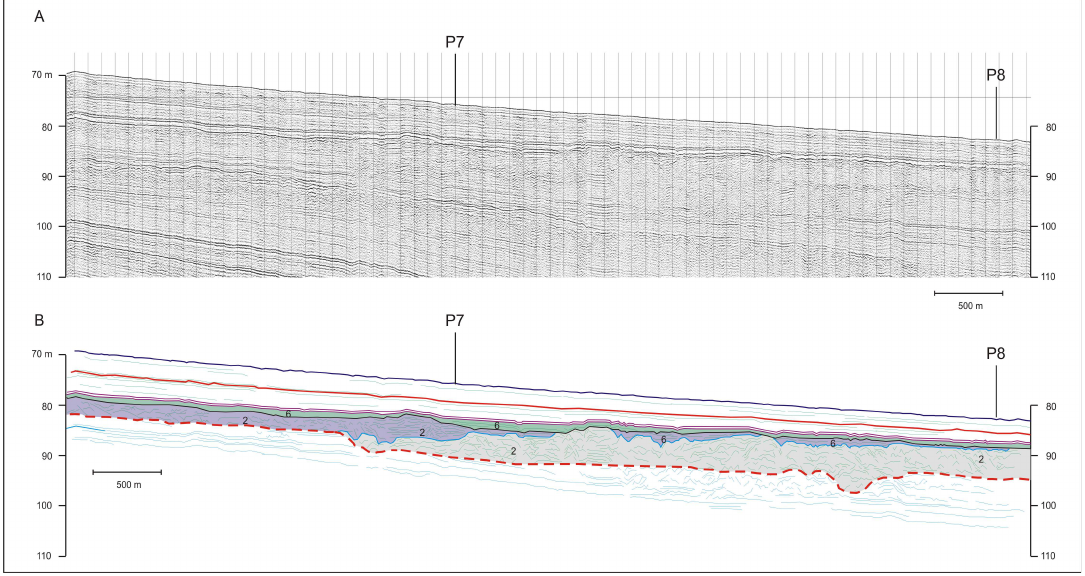
Figure 5. Part of seismic profile T1. Seismic section ( A ) and interpretation ( B ) showing, among others, unit A l . Note the central part of the unit, made up of seismic facies 2 and modelled into a dune-like / barrier